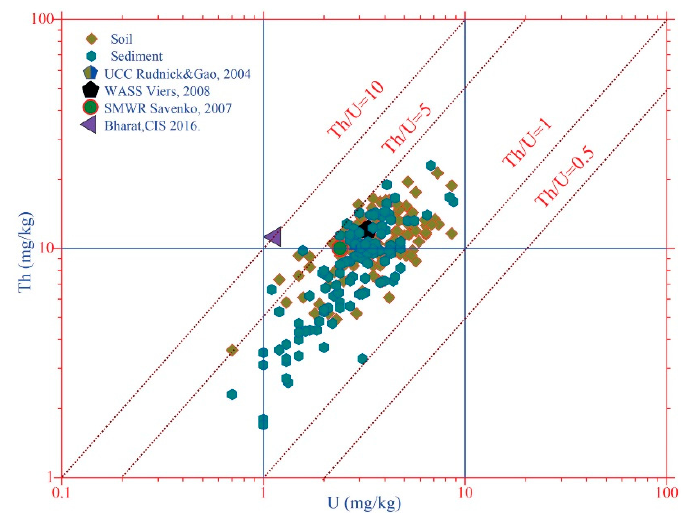
Figure 5. The distribution of the contents of thorium and uranium relative to their ratio in soils and sediments.